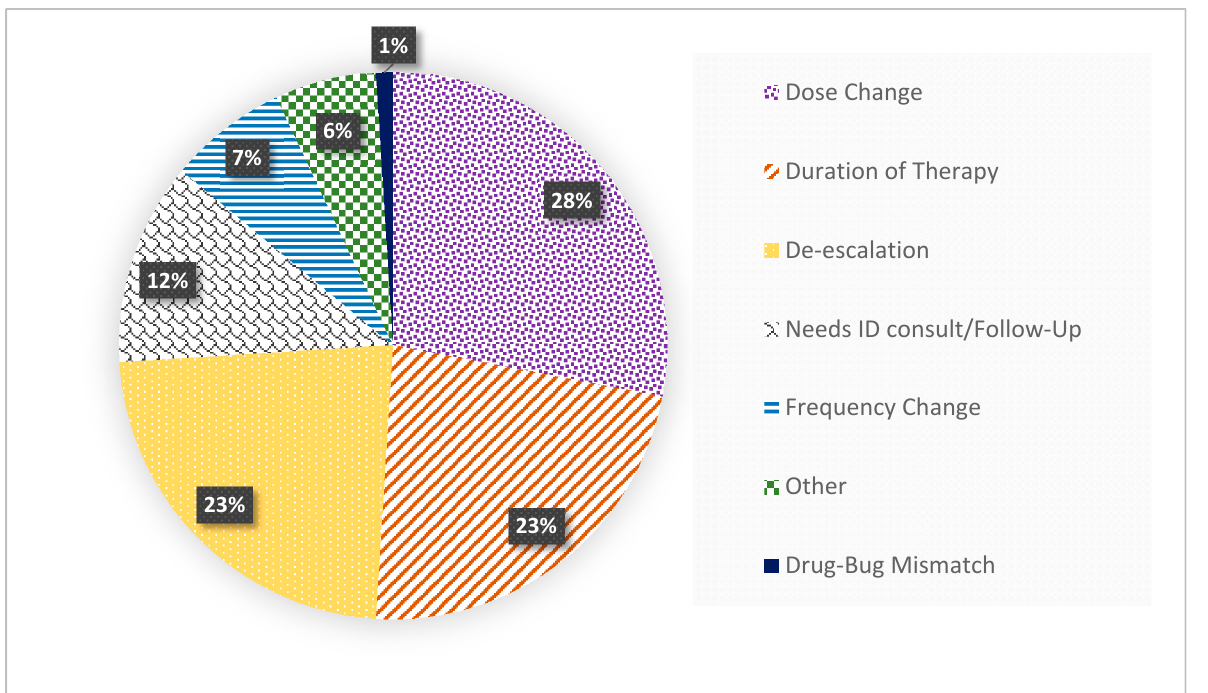
Figure 1. Distribution of antimicrobial stewardship interventions (n = 81) for patients receiving carbapenems during April 2019. ID, Infectious Disease.